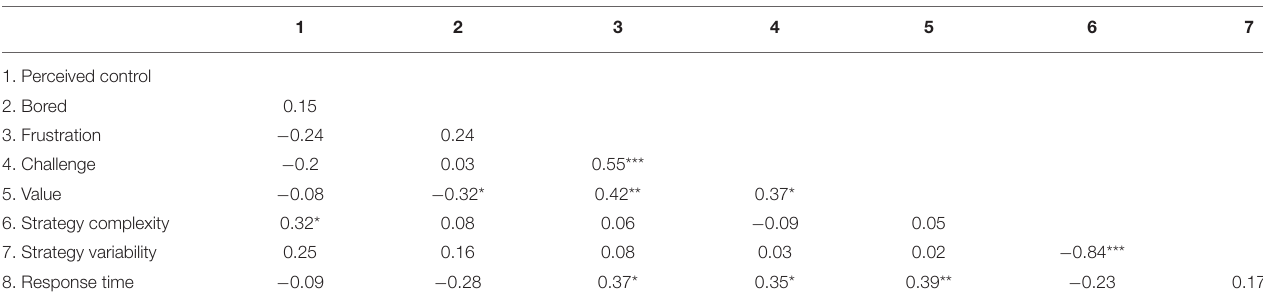
TABLE 5B | Zero-order correlations of all study variables and their significance levels (Study 2: Prospective Control). 1 2